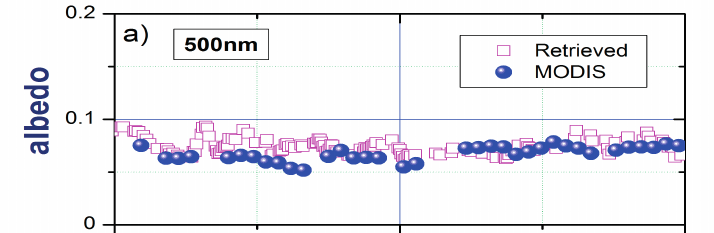
Figure 6. Time series of the MFRSR-retrieved areal-averaged surface albedo (magenta) and MODIS-derived albedo (blue) at three MFR/MFRSR wavelengths: 500 nm ( a ); 673 nm ( b ); and 870 nm ( c ) for one-year period (2010). In contrast to Figure 5, these time series are segregated by wavelength and focus on the comparison of the retrieved and MODIS-derived